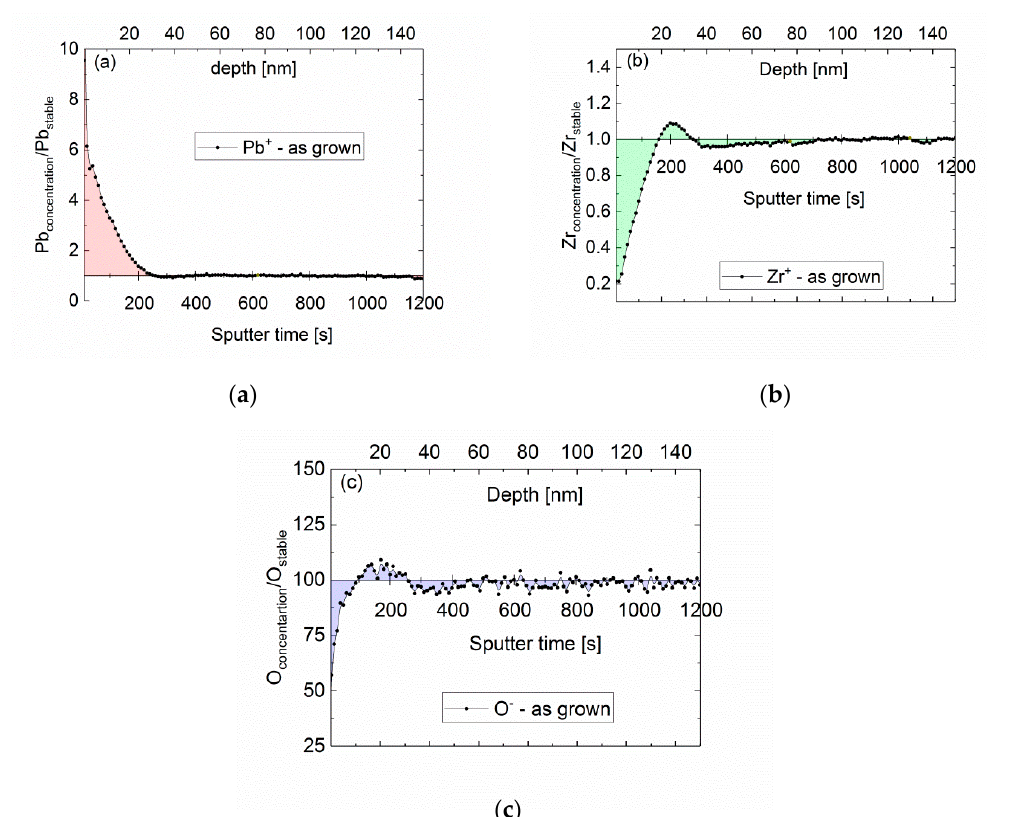
Figure 2. Depth profiles obtained by the TOF-SIMS method for ( a ) lead, ( b ) zirconium and ( c ) oxygen in virgin PbZrO 3 crystal [31] (index “stable” means the stable concentration of the element in the crystal